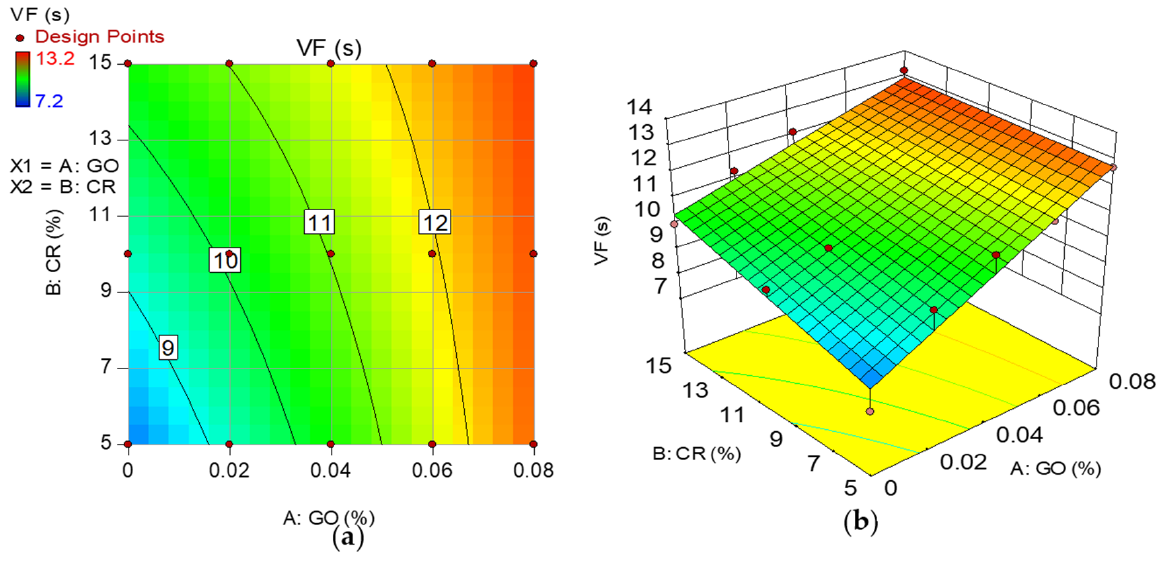
Figure 9. ( a ) 2D contour plot and ( b ) 3D response surface diagram for SF.